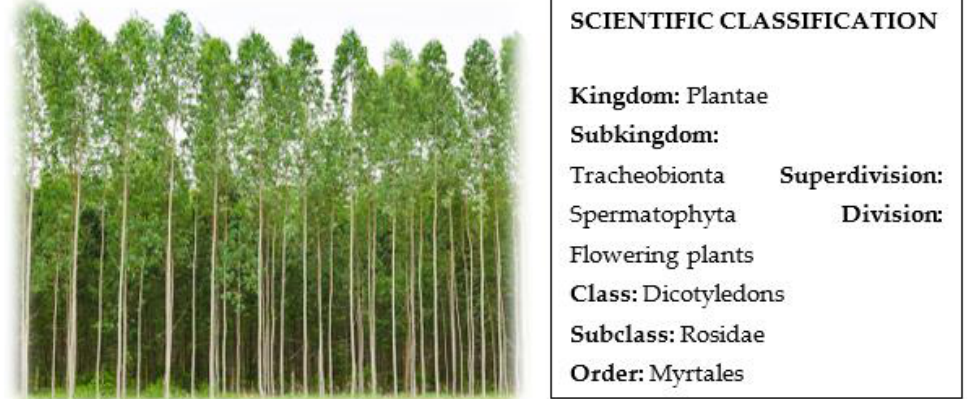
Figure 1. Tree known as Eucalyptus (Latin), Eucalypt (English), Neelgiri (Hindi) and Sugandh Patra (Sanskrit).